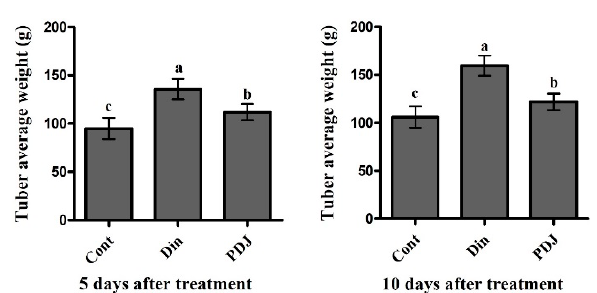
Fig. 3: Effect of each treatment on the average weight of tubers (Cont; Control, Din; Diniconazole, PDJ; Prohydrojasmon). The differences between the mean values were determined using a DMRT at P < 0.05. The results were graphically presented using GraphPad Prism (version 5.0, San Diego, CA, USA). The SAS 9.1 was used for DMRT analysis.